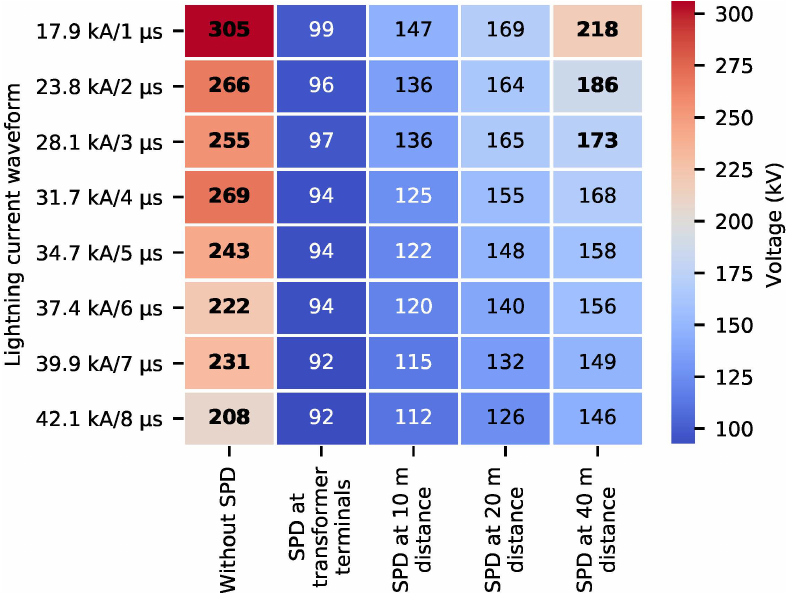
Figure 6. Transformer overvoltage amplitudes as a function of the arrester lead length and the steepness of the impinging surge.